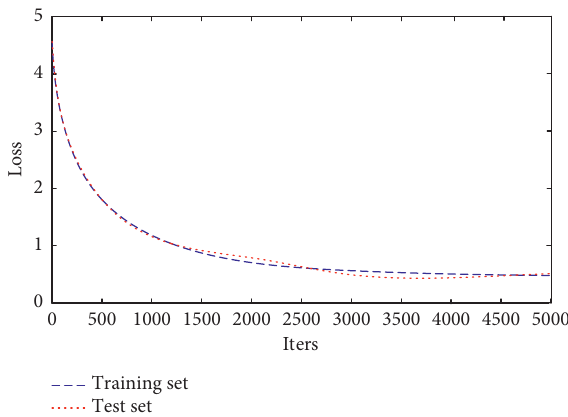
Figure 8: Experimental loss change diagram of facial expression recognition based on improved AlexNet